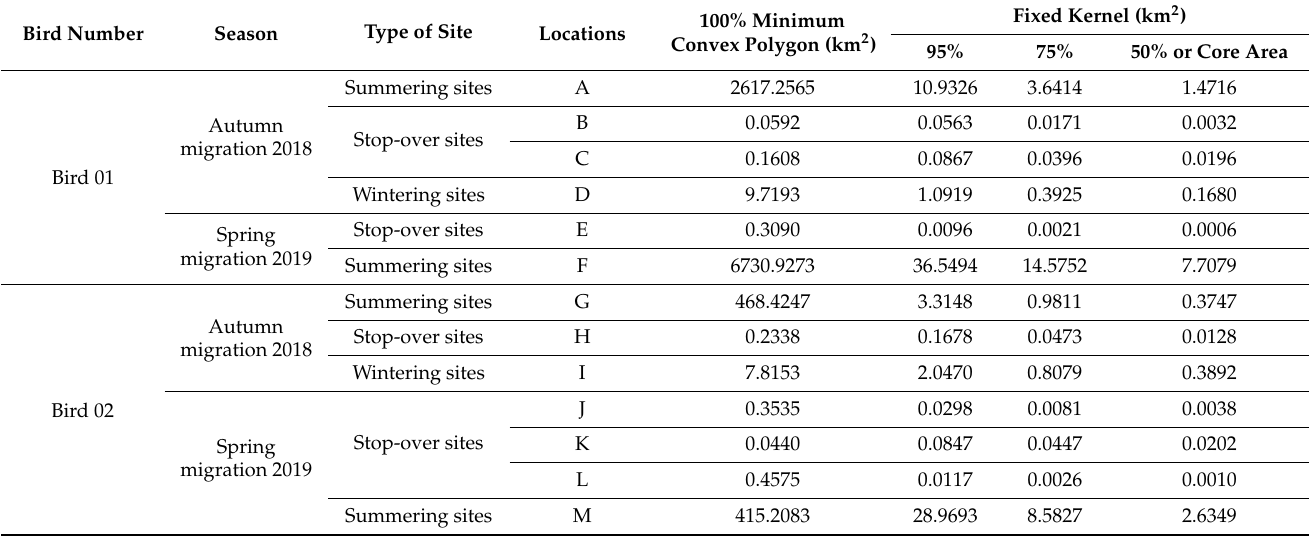
Table 3. The results of home range of two Chinese Sparrowhawks in different location sites.